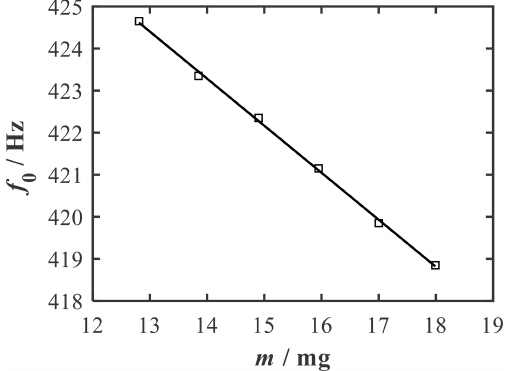
Figure 15. Resonant frequency depending on the sample mass from piezoresistive measurement of the three-layer chip. A sensitivity of − 1 . 12Hzmg − 1 can be obtained from the regression